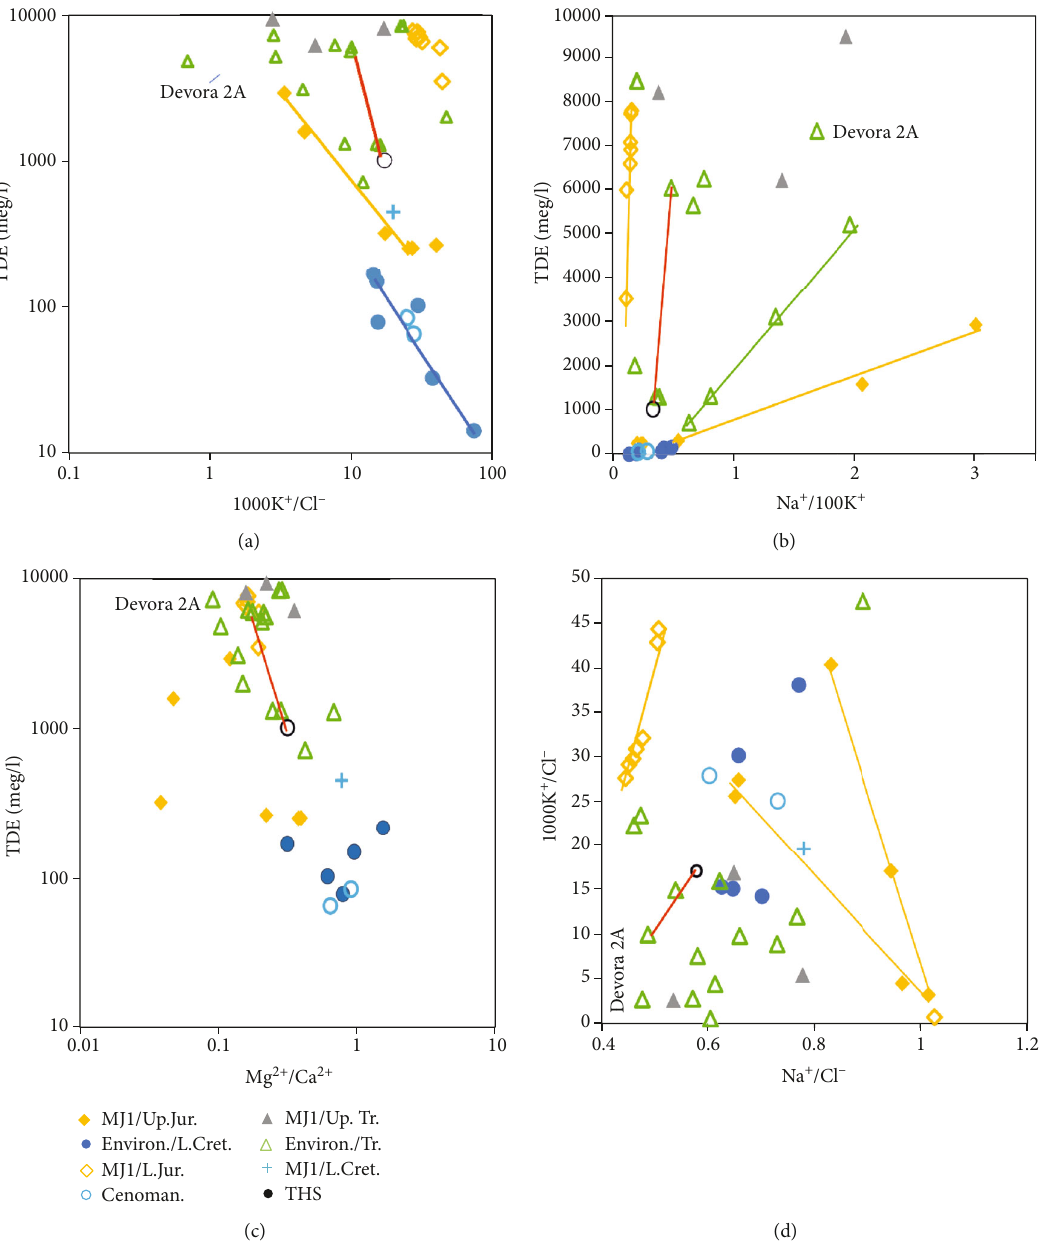
Figure 5: Various cross plots indicating correlations. Association of THS and shallow Rosh Pinna 1 is indicated by red lines. Devora 2A is not on this mixing line. The yellow, blue, and green lines indicate brines either mixing with other K + -rich brines or interacting with K + -rich evaporates. Ratios are based on